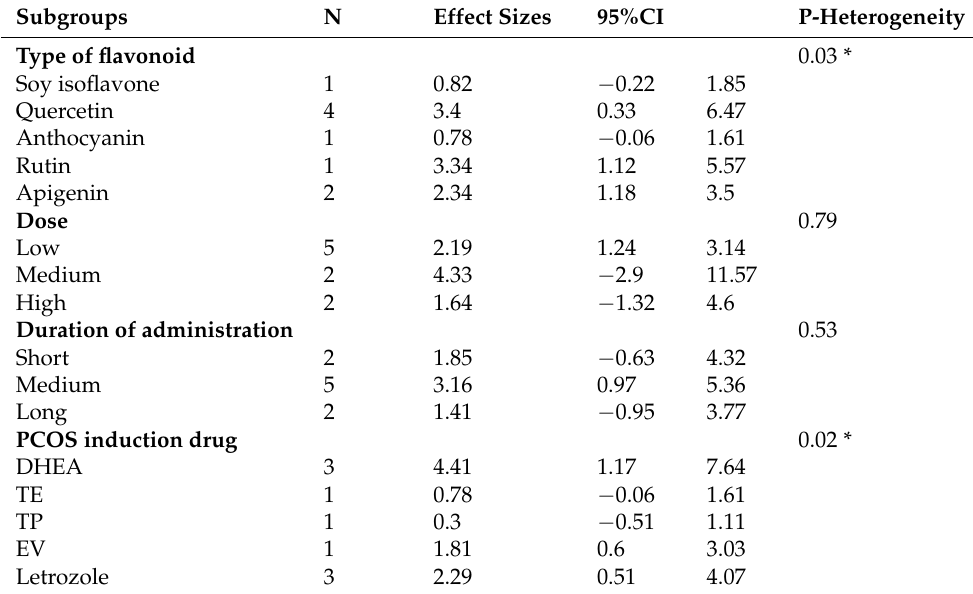
Table 3. Subgroup analysis of flavonoids effect on count of corpus luteum.